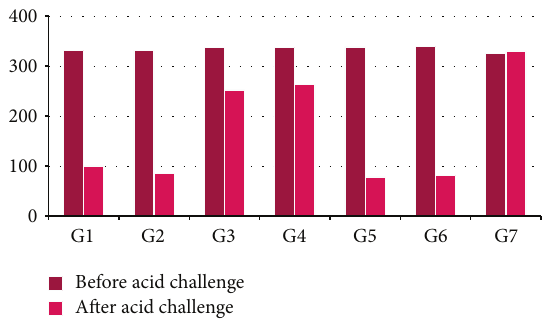
Figure 4: Knoop microhardness before and after acid challenge.